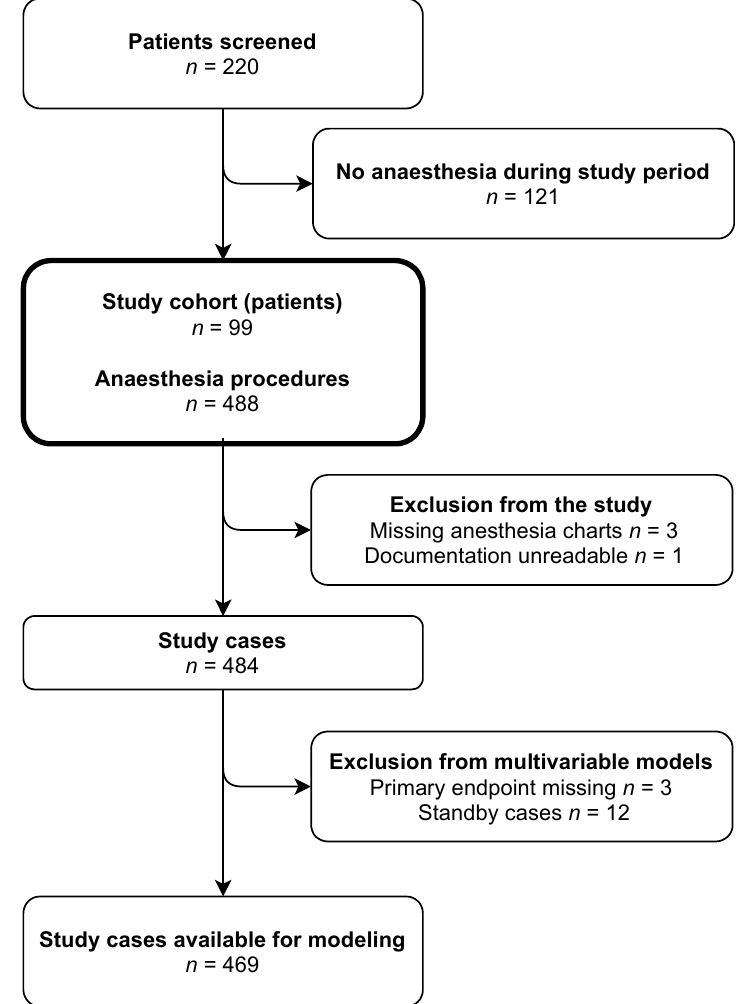
Figure 1. Flowchart of the study inclusion process.